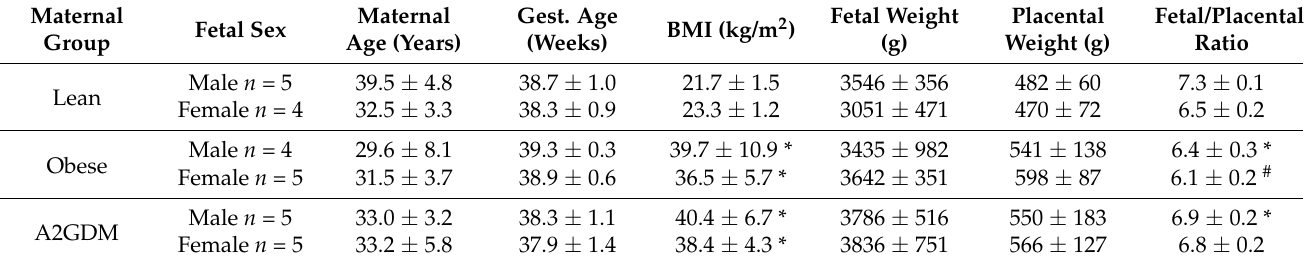
Table 1. Patient Characteristics. Mean ± SD. * p < 0.05 vs. Lean, # p < 0.05 vs. A2GDM of correspond- ing